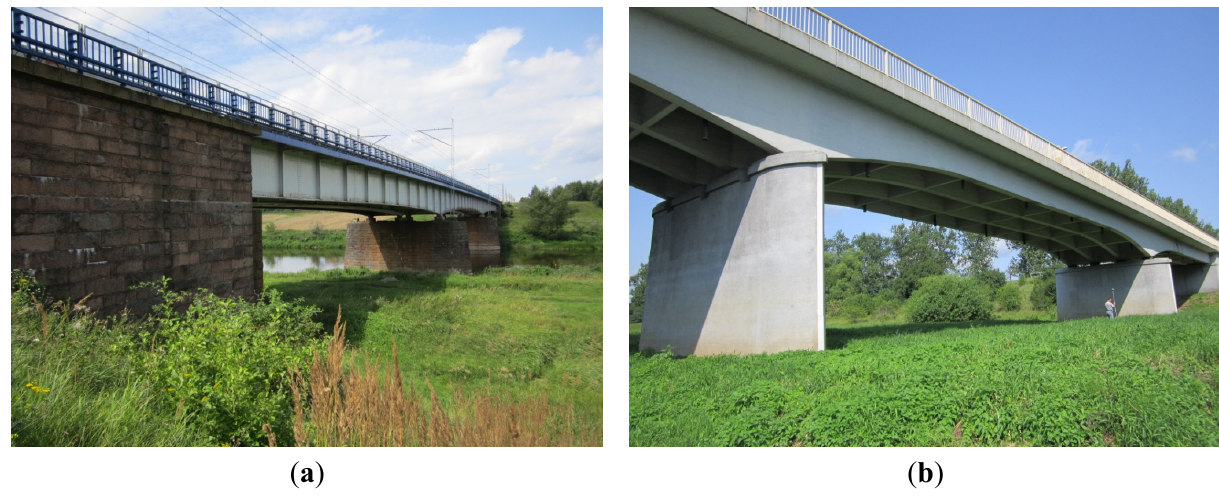
Figure 2. The existing bridges located in the town of Wronki: ( a ) railroad bridge in km 168 + 773 (downstream); ( b ) road bridge in km 169 + 871 (upstream)